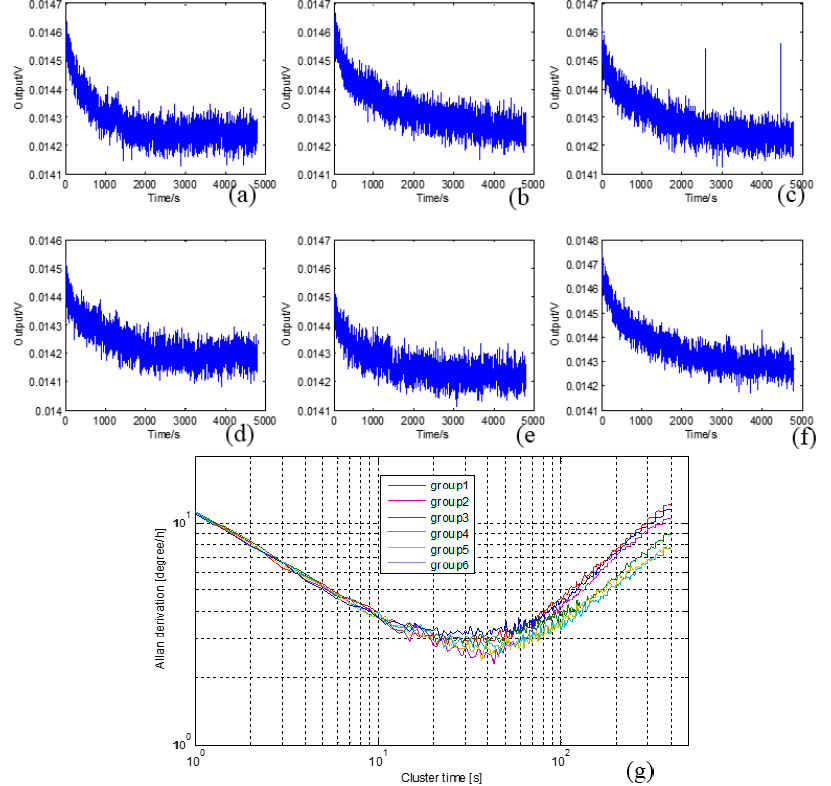
Figure 17. ( a ) – ( f ) Six groups’ CSC system bias repeatability test curves; ( g ) Allan derivation of the six groups’ curves.